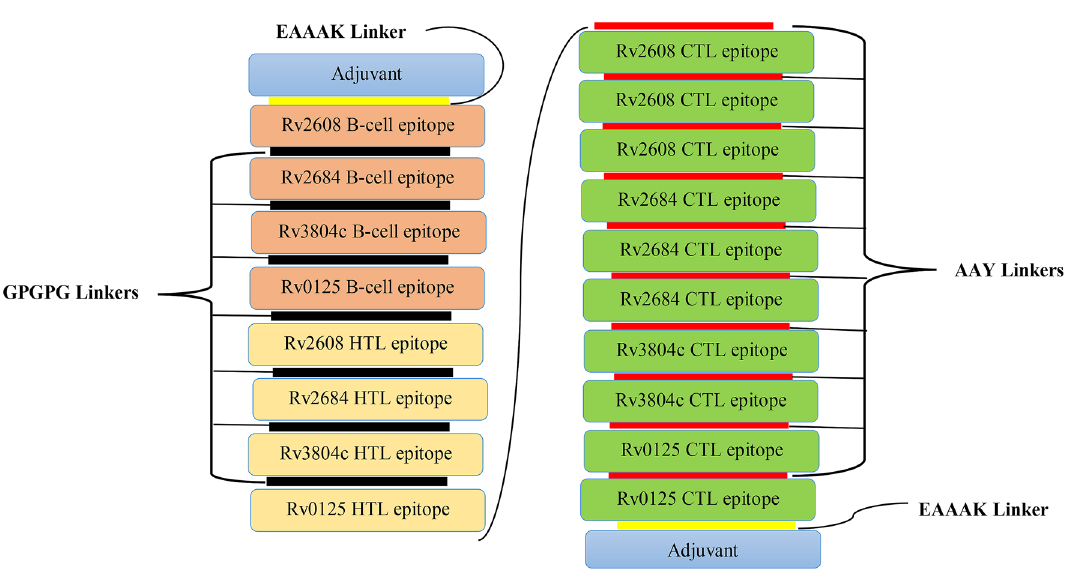
Figure 1. Schematic presentation of the final multi-epitope vaccine peptide. The 309-amino acid long peptide sequence containing adjuvant (blue) at both N and C terminal was linked with the multi-epitope sequence through an EAAAK linker (yellow). B cell epitopes and HTL epitopes are linked using GPGPG linkers (black) while the CTL epitopes are linked with AAY linkers